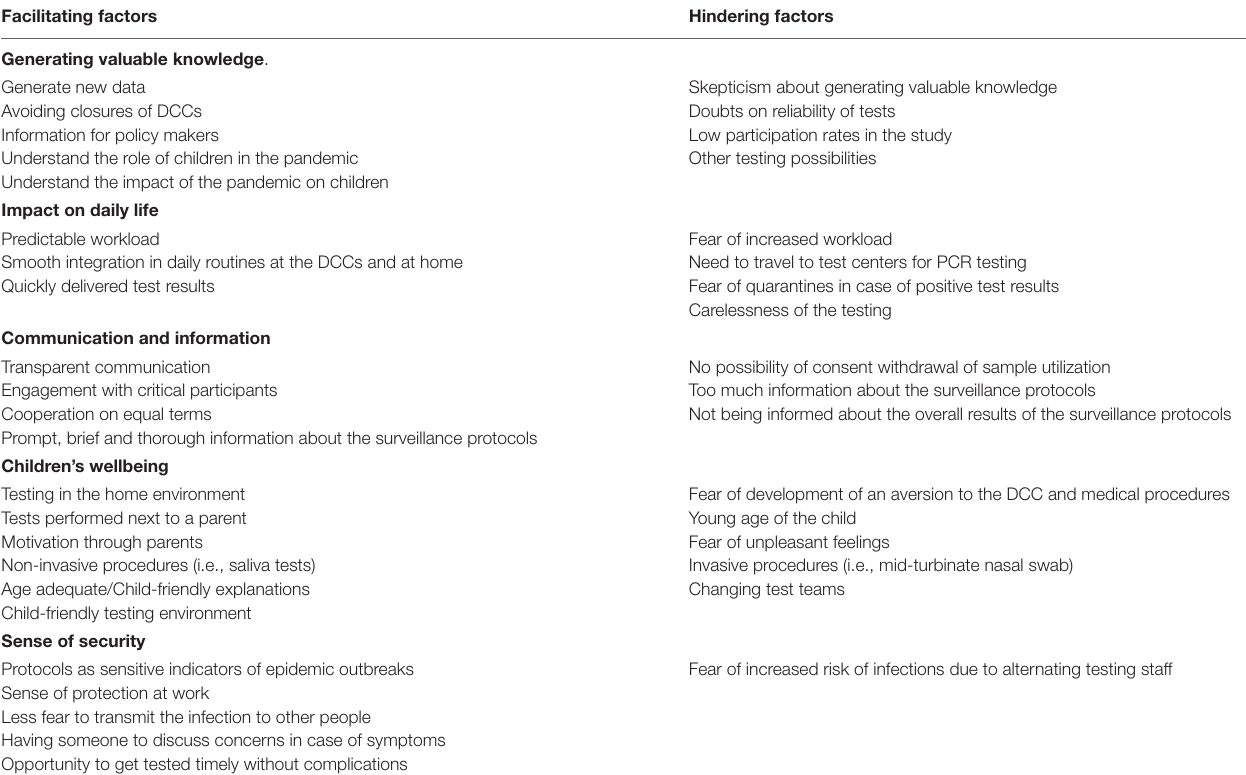
TABLE 3 | Facilitating and hindering factors of the implementation of the Wü-KiTa-CoV surveillance protocols in DCCs from the perspective of participants. Facilitating